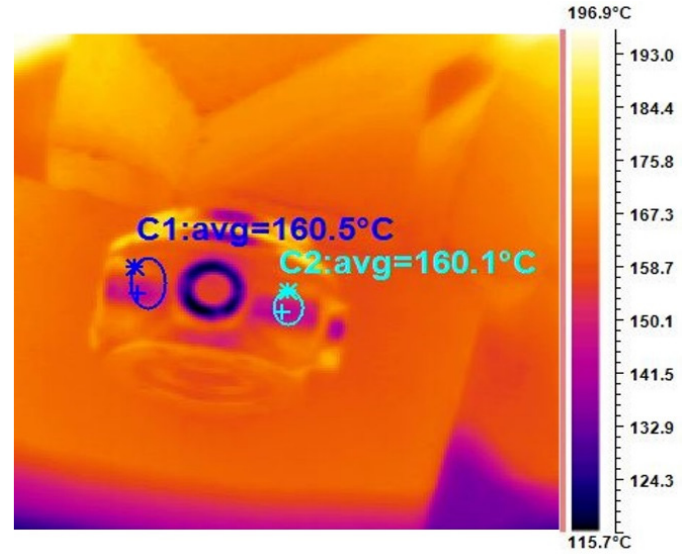
Figure 3. Bearing housing at 160 °C and emissivity of 0.74.